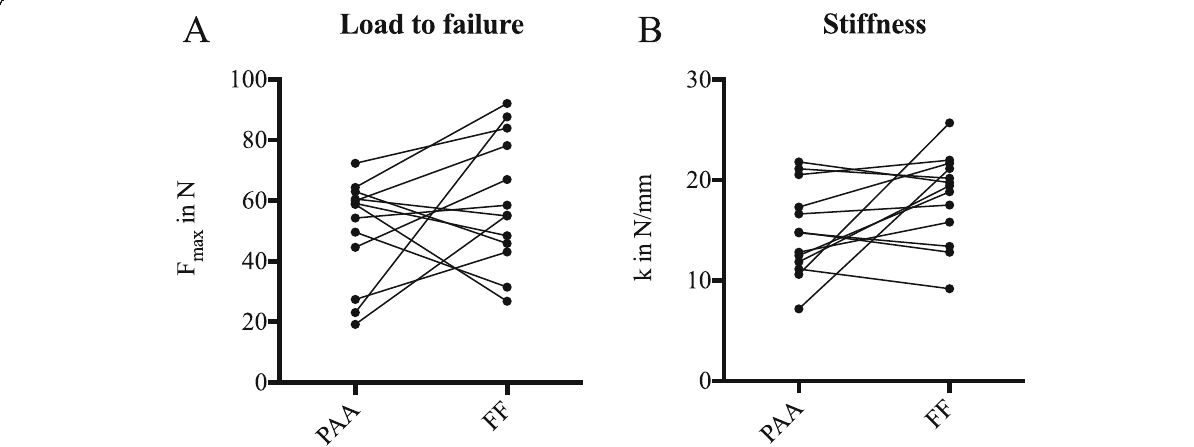
Fig. 2 Stiffness ( a ) and load to failure ( b ) determined by suture retention analysis of 13 pairs of menisci. No significant difference between peracetic acid (PAA) sterilised and fresh-frozen (FF) menisci could be demonstrated with regards to stiffness and load to